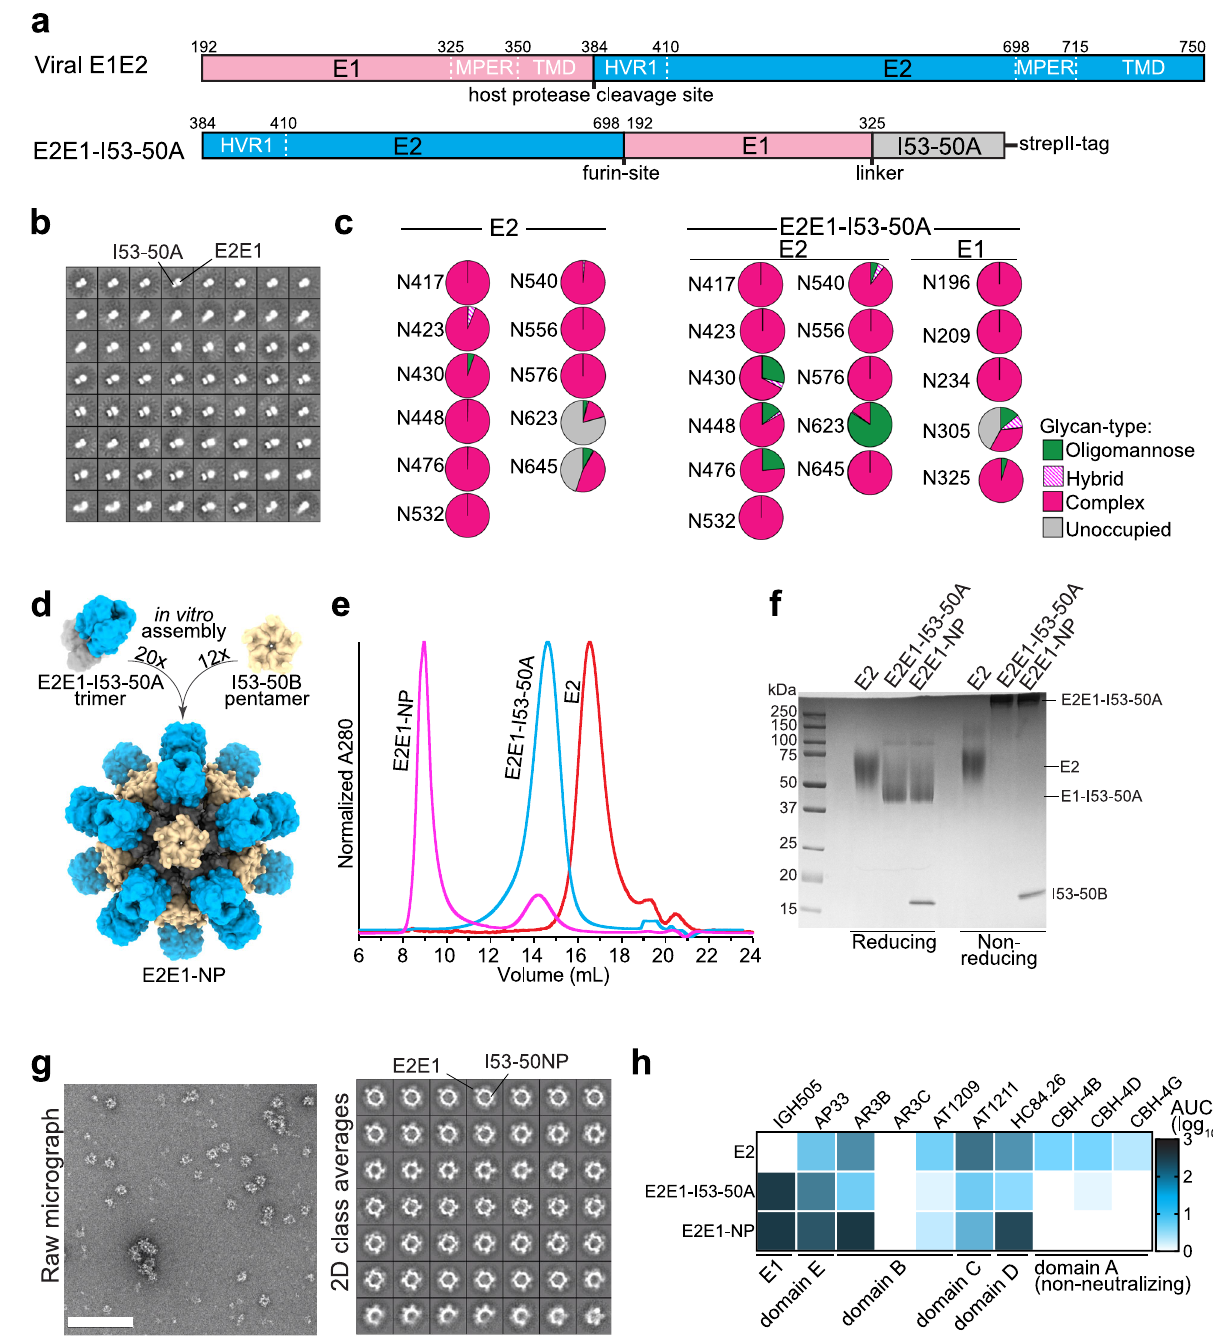
Fig. 1 | Design and characterization of a recombinant HCV E2E1 nanoparticle immunogen.a Top:linearrepresentationoffull-lengthE1E2withthehypervariable region 1 (HVR1), transmembrane domains (TMD), and hydrophobic membrane- proximalexternalregion(MPER)indicated.Bottom:thedesignofE2E1-I53-50A.The I53-50A.1NT1 (I53-50A)trimerization domain and E1 areseparated by a Gly-Ser-rich linker (GSGGSGGSGGSGGS). The amino acid numbers are based on the standard H77 polyprotein numbering 104 . The amino acidsequences are shown in Fig. S2 and anoverviewoftheotherdesignsaredepictedinFig.S1a. b NS-EM2Dclassaverages of SEC-puri fi ed E2E1-I53-50A trimers. The E2E1 and I53-50A moieties are indicated. c Site-speci fi cglycananalysisofE2andE2E1-I53-50AproducedinHEK293Fcellsand puri fi ed using Strep-Tactin followed by SEC. The relative occupancy and abun- dance of the different glycan species per potential N -glycosylation site (PNGS) are indicatedinpiediagrams:non-occupied(gray),complex(magenta),hybrid(white/